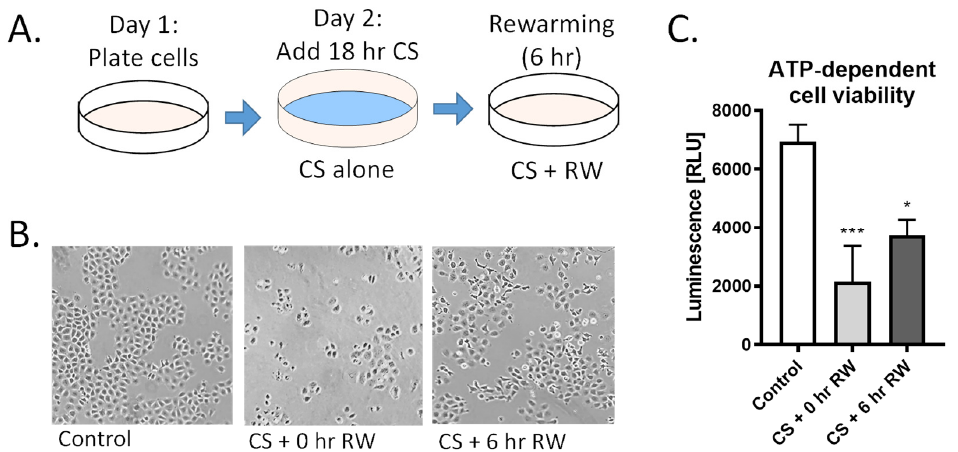
Figure 1. CS + RW induces NRK cell injury. ( A ) NRK cells were exposed to CS for 18 h in UW solution followed by 6 h of RW. ( B ) Representative images of microscopic evaluation used for qualitative assessment of cell injury after CS and CS + RW. After 18 h, CS followed by 0 h and 6 h RW, NRK cells exhibited altered cell morphology indicated by stretched, rounded, and swollen cells. ( C ) Cytotoxicity was assessed by a luminescent cell viability assay. ATP-dependent viability was decreased in both CS and CS + RW compared to control. One-way ANOVA followed by Tukey’s post-hoc test. n = 5; ±SEM. * p < 0.05, *** p < 0.001.